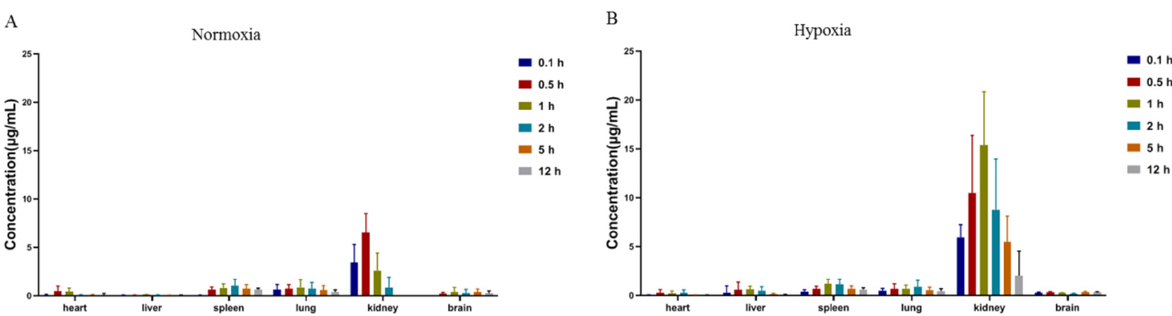
Figure 5. Tissue distribution of acipimox in rats with and without hypoxia after oral administration to rats ( n = 6 ). ( A ) Tissue distribution of acipimox in normoxic rats; ( B ) Tissue distribution of acipimox in hypoxic rats.